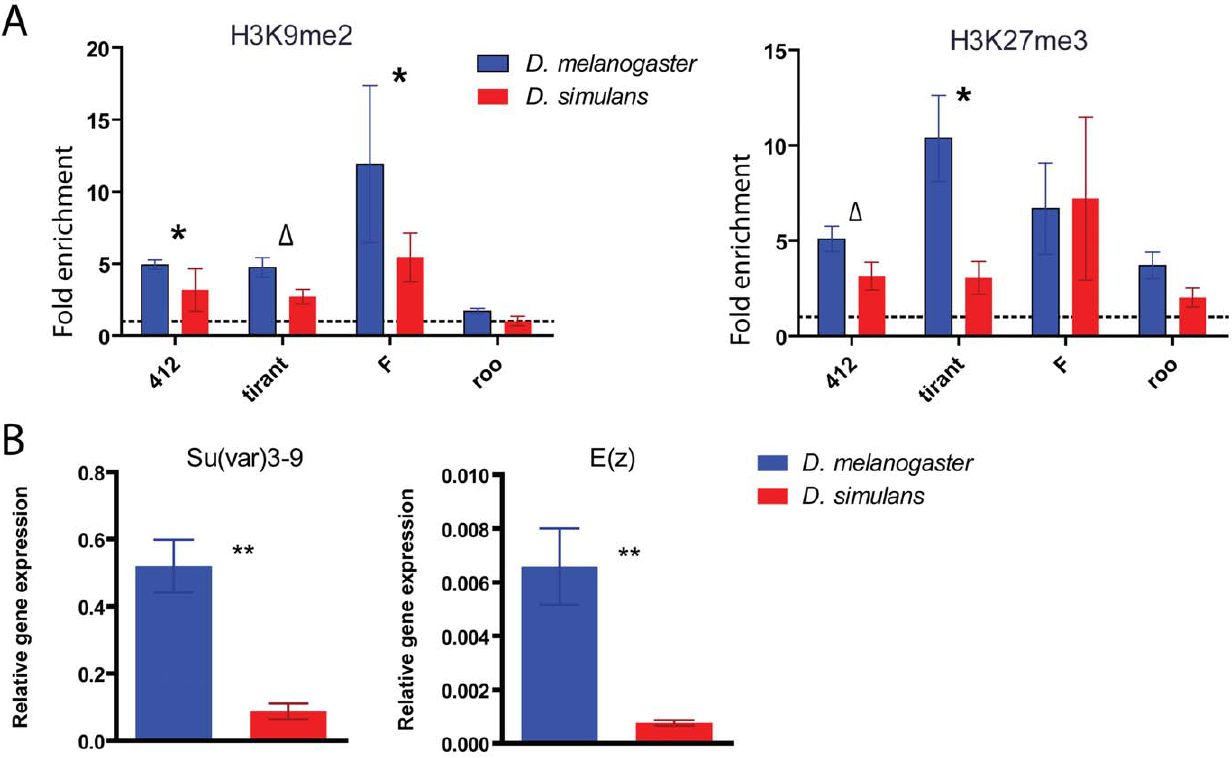
Figure 3. D.melanogaster and D.simulans display differences in TE chromatin state and expression of epigenetic writers. A. Fold enrichment of H3K9me2 (left panel) and H3K27me3 (right panel) for the four transposable elements studied are depicted per species (mean 6 SE). Roo copies show a significant lack of H3K9me2 (Mann Whitney test, p-value , 0.05). Histone fold enrichment of each TE family was compared between species and the results of the Mann Whitney test are shown (p-value * , 0.05 and D , 0.1). B. Quantification of RNA steady-state levels of the methyltransferases responsible for H3K9me2 and H3K27me3 deposition (mean 6 SE). D. melanogaster (blue), D. simulans (red). Mann Whitney P- values between species are shown with asterisks (p-value ** , 0.001).